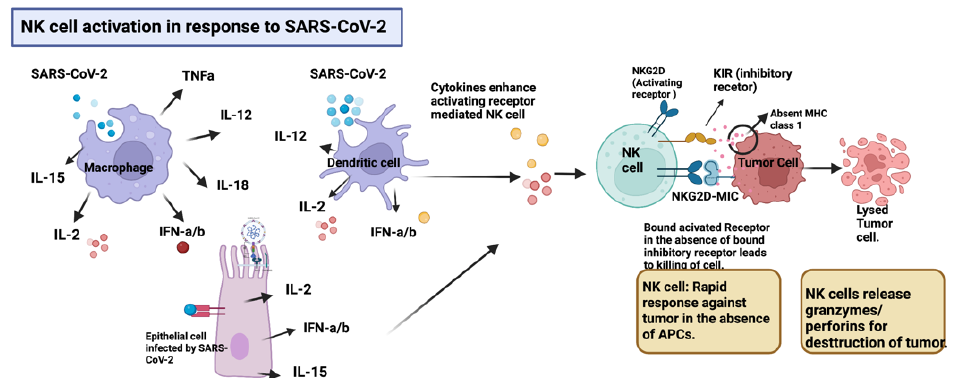
Figure 1. Inflammatory cytokines comprising IL-12, IL-15, IL-2, IFN- α , and INF- β produced by various cells including macrophages, dendritic, and epithelial lung cells in response to SARS-CoV-2 upregulate the expression of activating receptors (NKG2D) in NK cells, promoting a rapid response against tumor cells in the absence of APCs. The downregulation of MHC class I presentation by tumor cells as an evasion mechanism, triggers the activation of NK cells. Upon activation, NK cells release granzymes and perforins, which destroy the tumor. Created with